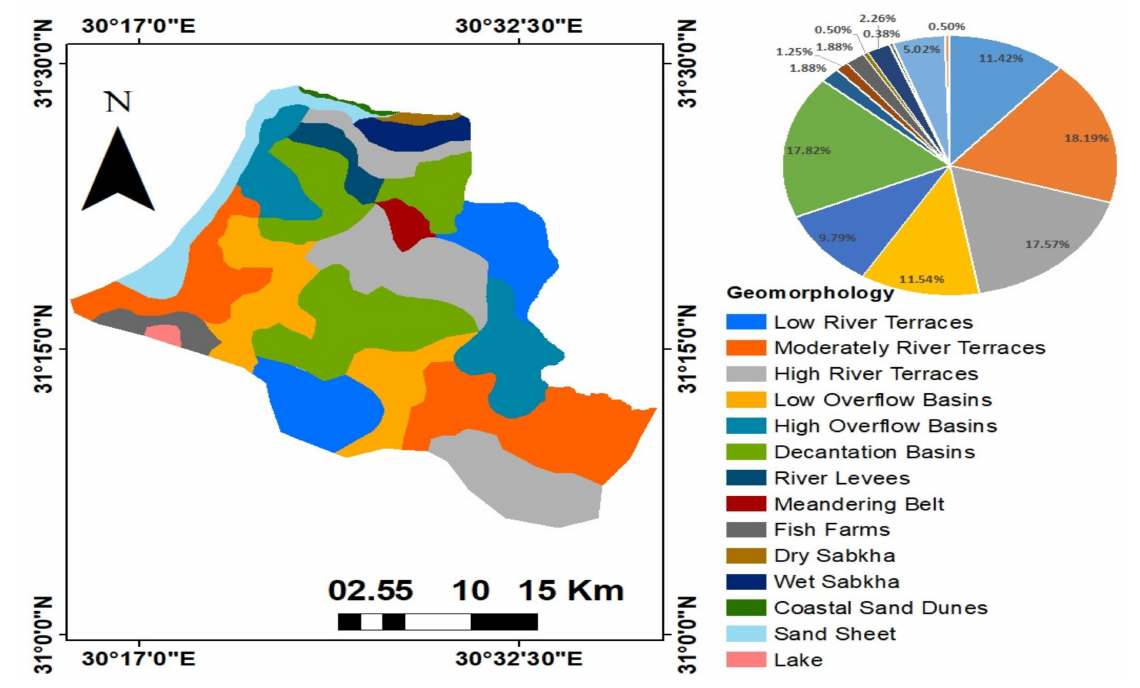
Figure 4. Geomorphological map illustrating the study